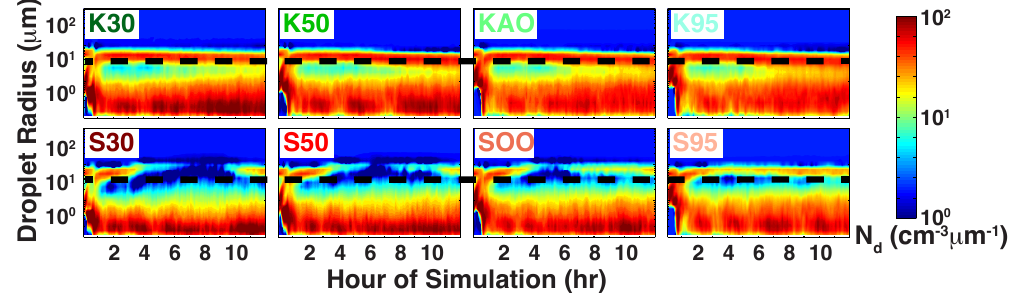
Fig. 10. Domain-averaged cloud-top size distributions for simulations featuring different aerosol soluble mass fractions at 5-min resolution. The top row includes simulations assuming Kaolinite as insoluble material, while the bottom row includes simulations assuming Soot. The dashed line indicates a radius of